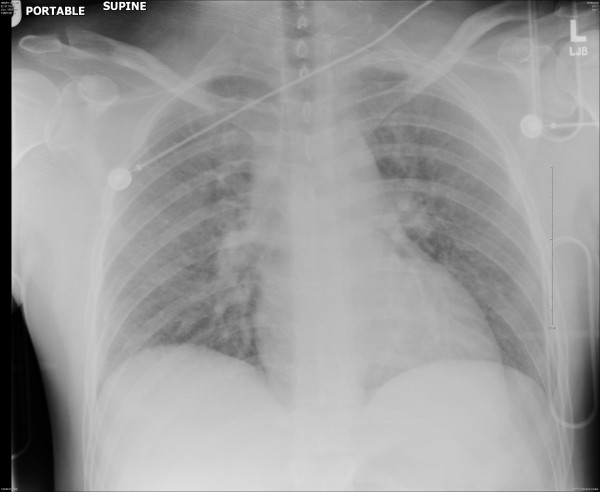
The chest radiograph taken in the trauma bay does not demonstrate acute intrathoracic injury.